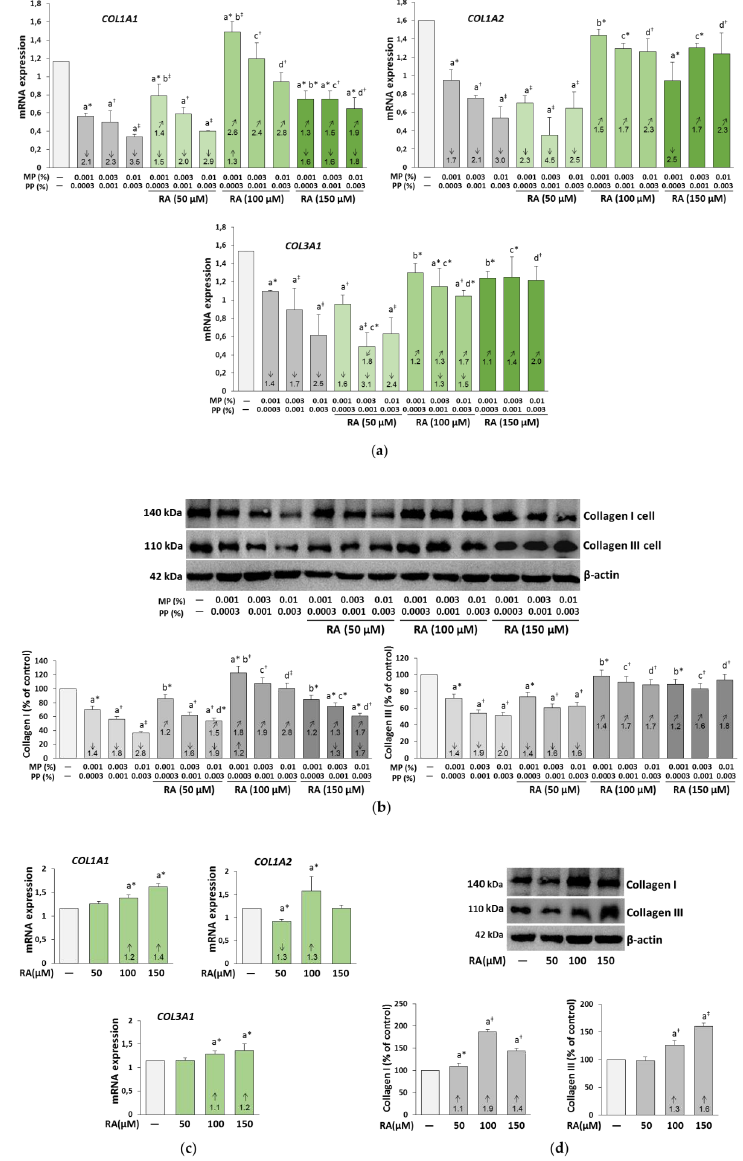
Figure 3. The influence of rosmarinic acid (RA) on the expression of COL1A1 and COL1A2 genes coding collagen I, and COL3A1 coding collagen III ( a , c ); on collagen I and III protein ( b , d ), in the fibroblasts treated with methylparaben (MP) and n-propylparaben (PP) ( a , b ); and untreated cells ( c , d ). Expression of genes was assayed by real-time PCR, values represent the mean ± SD of three experiments done in duplicate ( a , c ). Representative gels of Western blotting, the intensity of collagen bands was quantified by densitometry and normalized to β -actin, values represent the mean (% of control) ± SD of three experiments ( b , d ). Statistically significant di ff erences are marked as: a vs. control, b vs. 0.001% MP and 0.0003% PP, c vs. 0.003% MP and 0.001% PP, d vs. 0.01% MP and 0.003% PP; * p < 0.05; † p < 0.01; ‡ p < 0.001. The values in the bars show a factor of change in comparison to the control ( ↑ , increase; ↓ , decrease) or to the respective samples treated with parabens alone (MP and PP) ( (cid:37) , increase; (cid:46) ,